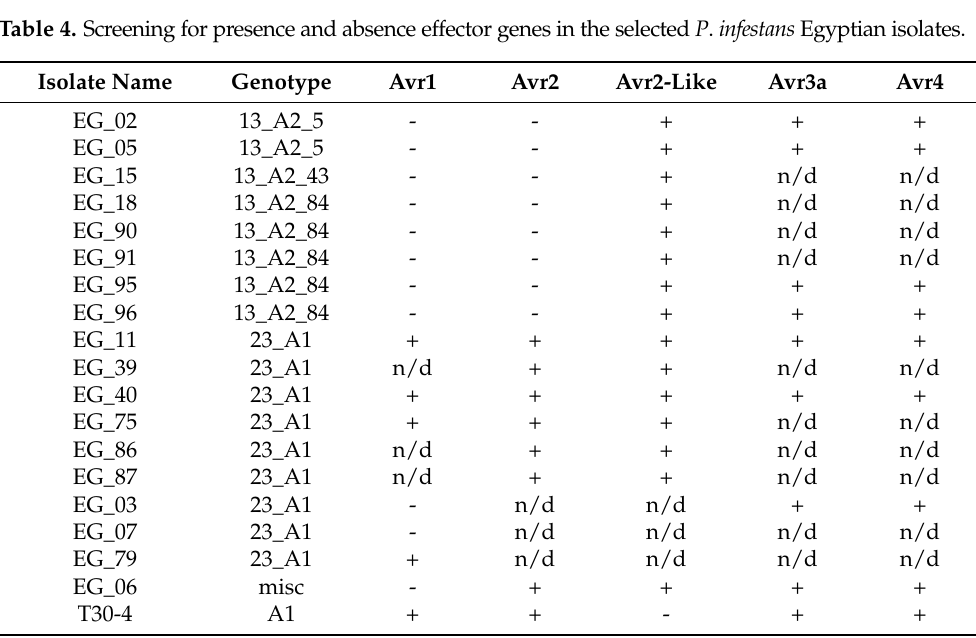
Table 4. Screening for presence and absence effector genes in the selected P . infestans Egyptian iso- lates.